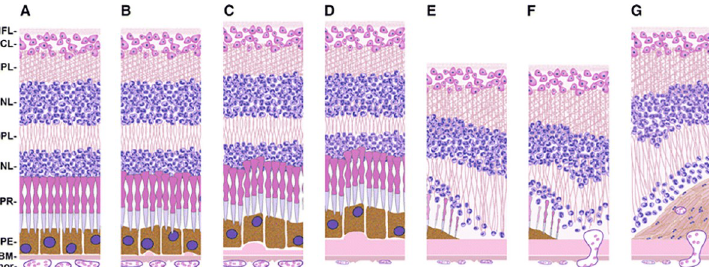
Fig 1. Diagram illustrating the Sarks stages of AMD. a Sarks I: normal control. b Sarks II: few small drusen. c Sarks III: early AMD with thin continuous sub-RPE deposits. d Sarks IV: intermediate AMD with thick sub-RPE deposits overlying degenerating choriocapillaries. e Sarks V: geographic atrophy. f Sarks V: choroidal neovascularization. g Sarks VI: disciform scar. NFL = Nerve Fiber Layer, GCL = Ganglion Cell Layer, IPL = Inner Plexiform Layer, INL = Inner Nuclear Layer, OPL = Outer Plexiform Layer, ONL = Outer Nuclear Layer, PR = Photoreceptors, RPE = Retinal Pigment Epithelium, BM = Bruch’s Membrane, chor = choroid. Reprinted under a CC BY license, with permission from publisher SpringerNature, original copyright 2014